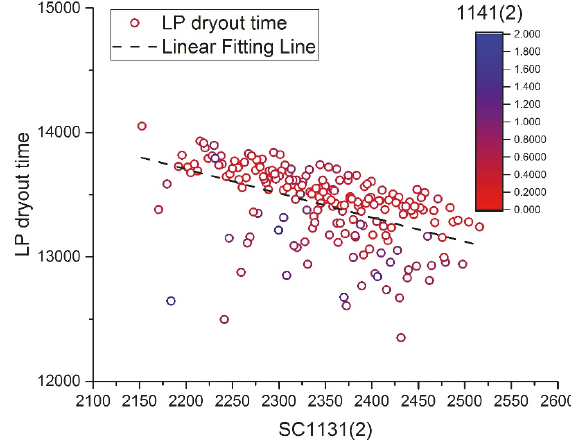
Figure 10: The scatter plot of first LP dryout time versus SC1141(2).